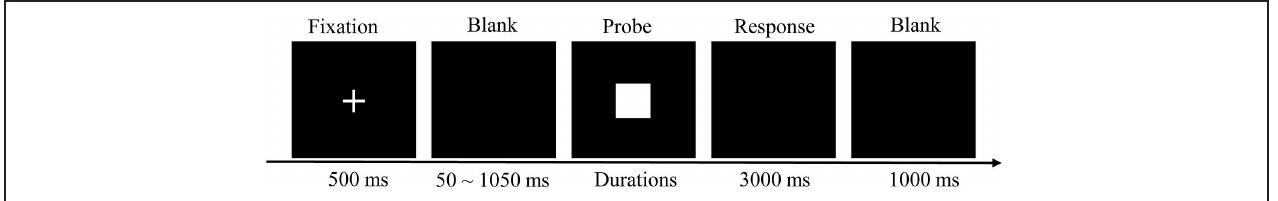
FIGURE 1 | Trial sequence of the test phase in the temporal bisection